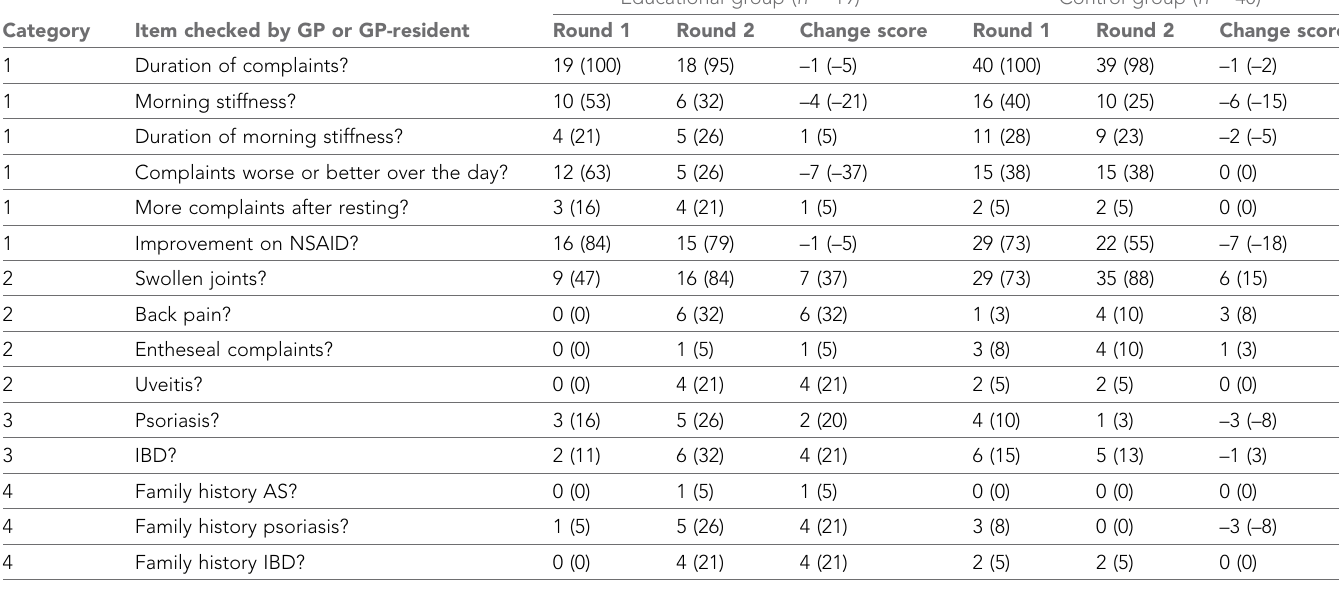
The values are expressed as number (percentage) of GP(-residents). Numbers may not add up due to rounding. AS = ankylosing spondylitis. IBD = inflammatory bowel disease. NSAID = non-steroidal anti-inflammatory drug. SpA = spondyloarthritis. Category: 1 = differentiation between a mechani- cal or inflammatory origin of peripheral complaint; 2 = presence of swollen joints, back pain or entheseal complaints; 3 = presence of